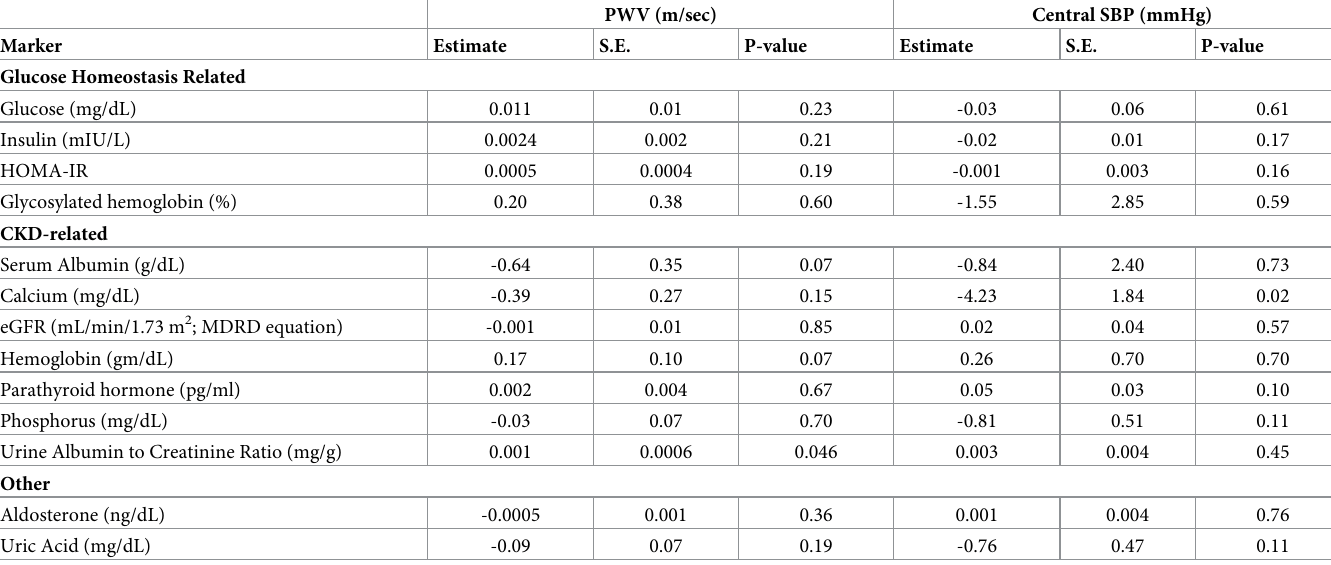
Table 3. Linear regression analysis of various markers with PWV and central SBP, adjusted for age, race, and